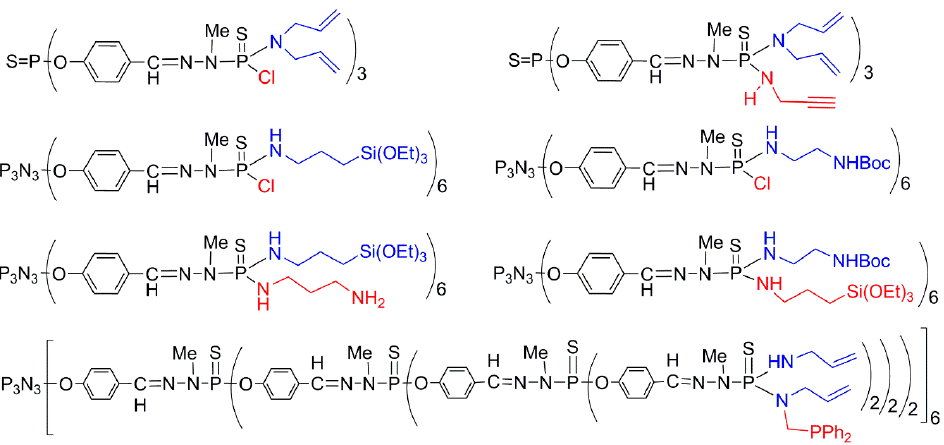
Figure 17. Examples of selective and sequential functionalization of each Cl on P(S)Cl 2 functions, or on a single NH function ( bottom ).